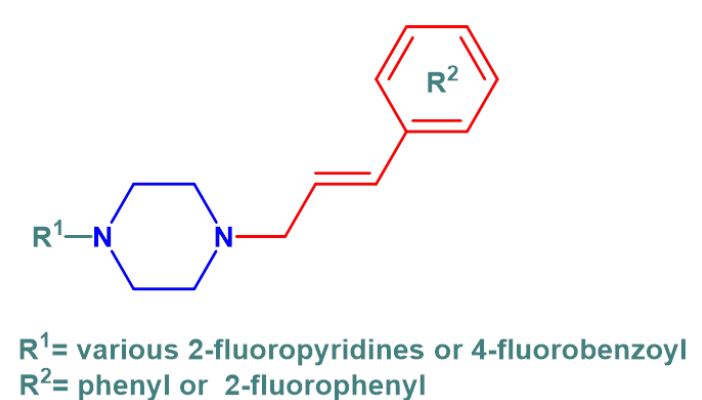
Figure 2. Design of fluorinated cinnamylpiperazines as potential MAO-B ligands. Fusion of the arylpiperazine (blue) and the cinnamyl pharmacophores (red) with different aryl fluorine-containing substituents.